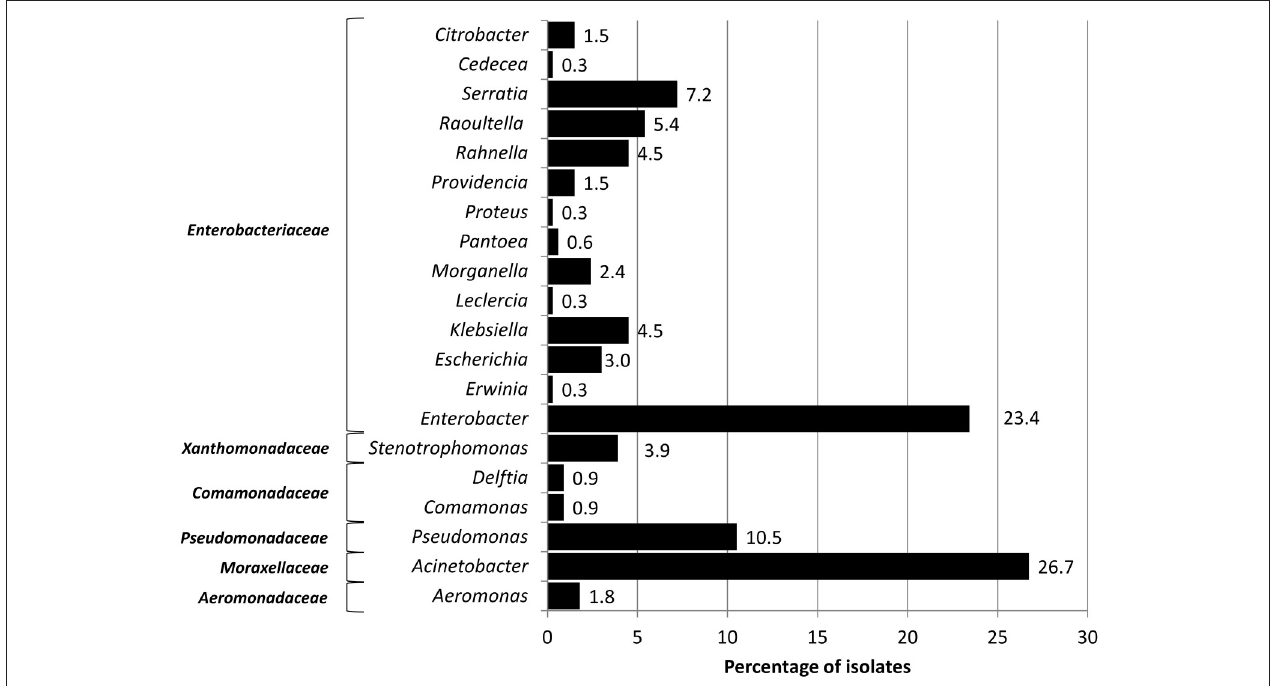
FIGURE 1 | Percentage of bacterial genera recovered from fruits and vegetables.